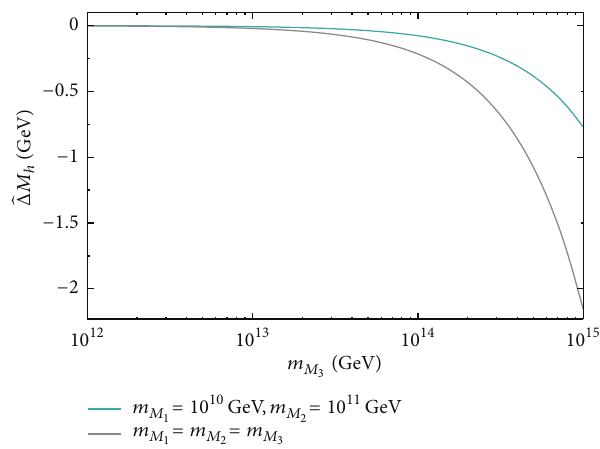
̂Δ𝑀 𝑚 Figure 8: ℎ as a function of 𝑀 3 for hierarchical (blue) and degenerate (grey) heavy neutrinos. The rest of input parameters are set to the reference values in